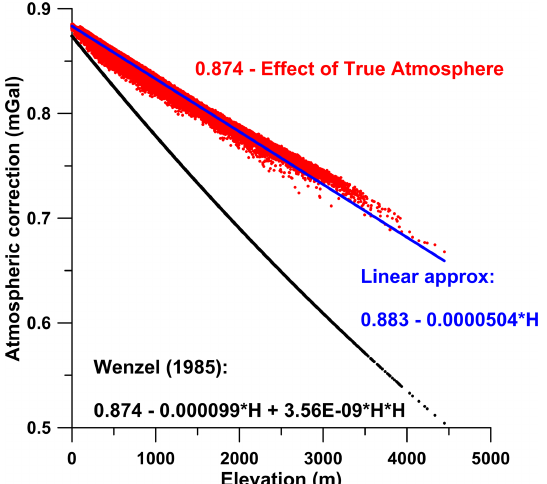
Figure 10. The summary effect of topography and bathymetry (densities of 2670 and − 1640kgm − 3 , respectively) from 166.7km around the whole